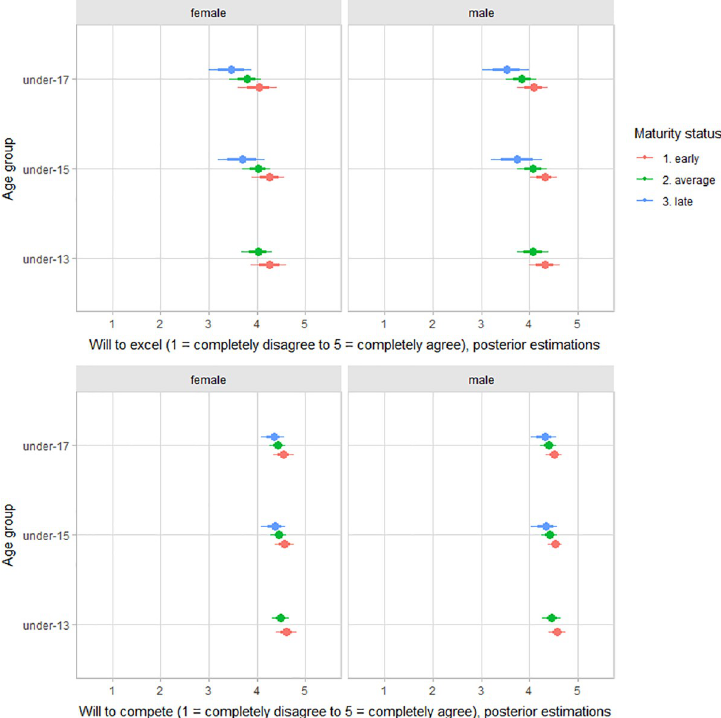
Fig 5. Posterior estimations and uncertainty (bold lines and thick ones represent 67% and 90% intervals, respectively) for will to excel (upper plot) and will to compete (lower plot) scores by age group and contrasting age group by maturity